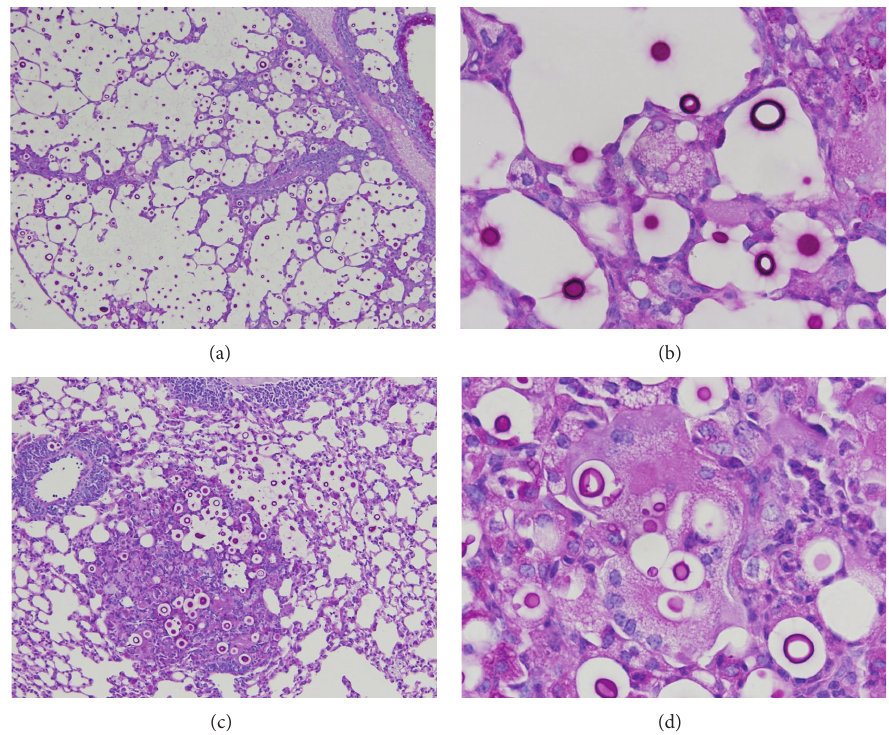
Figure 6: (a) Pulmonary sections of mice infected with C. gattii R265 exhibited eccentric pulmonary enlargement (periodic acid Schiff (PAS) reaction, × 200). (b) Pulmonary sections of mice infected with C. gattii R265 showed multinucleated giant cells with a foamy cytoplasm, and a small number of nuclei that were loosely aggregated (PAS reaction, × 1000). (c) Pulmonary sections of mice infected with C. neoformans H99 showed multiple well-demarcated nodular lesions, but no alveolar expansion was observed (PAS reaction, × 200). (d) Pulmonary sections of mice infected with C. neoformans H99 showed multinucleated giant cells with a well-developed and dense eosinophilic cytoplasm and a large number of nuclei (PAS reaction, ×